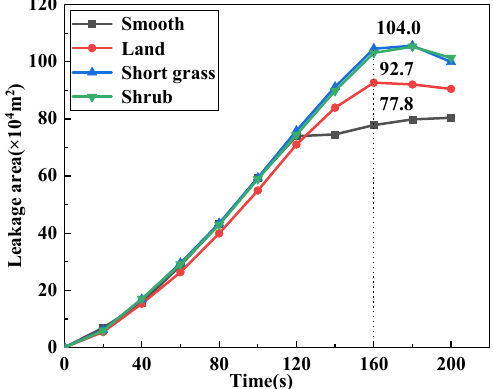
Figure 6. Trend of the crude oil leakage area on different surfaces.